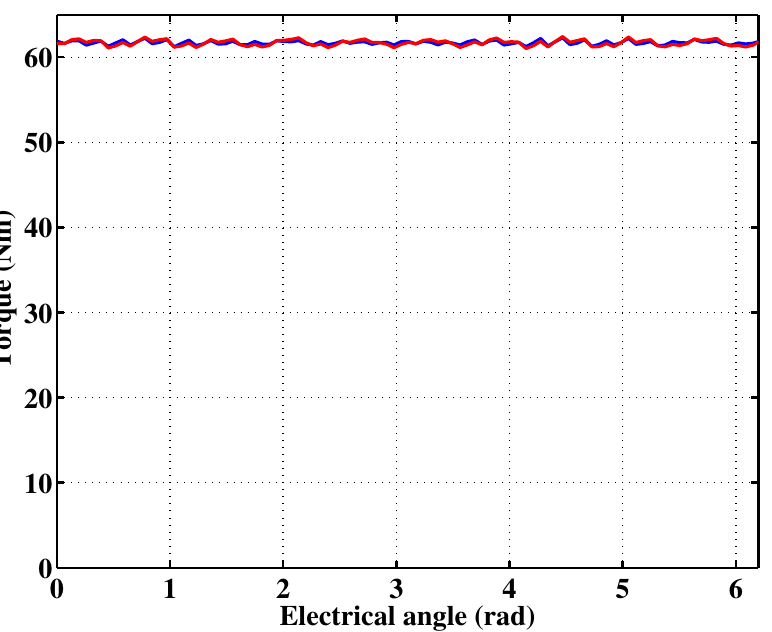
Figure 15. Torque-angle characteristics for the coil-rated current rms value of 14 A. Legend: same as in Figure 12.